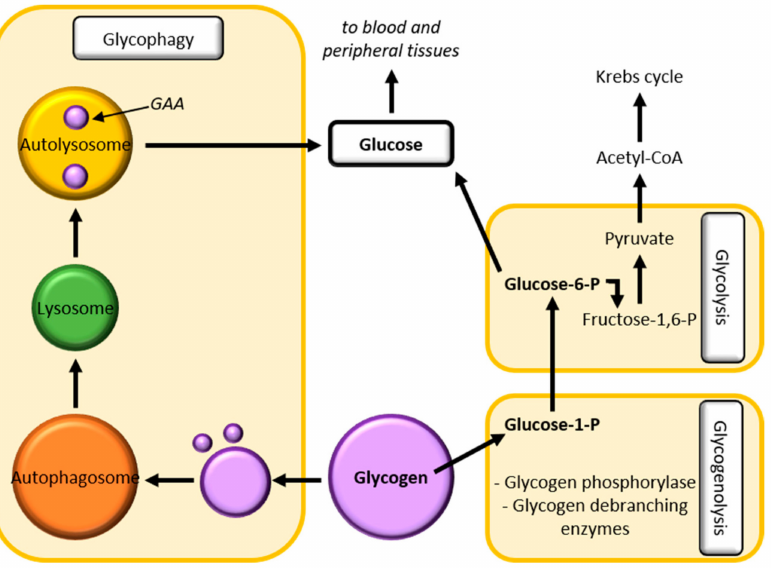
Figure 3. Glycogen Homeostasis. Schematic view of the main pathways involved in glycogen homeostasis: glycogenolysis, glycolysis and glycophagy. Glycogen (violet) is cleaved to glucose-1- phosphate during glycogenolysis and serves as a substrate for the glycolysis allowing the release of glucose. Glycogen homeostasis is also regulated by glycophagy in which glycogen is sequestered in lysosomes (green) and degraded to obtain glucose. Autolysosome in yellow, autophagosome in